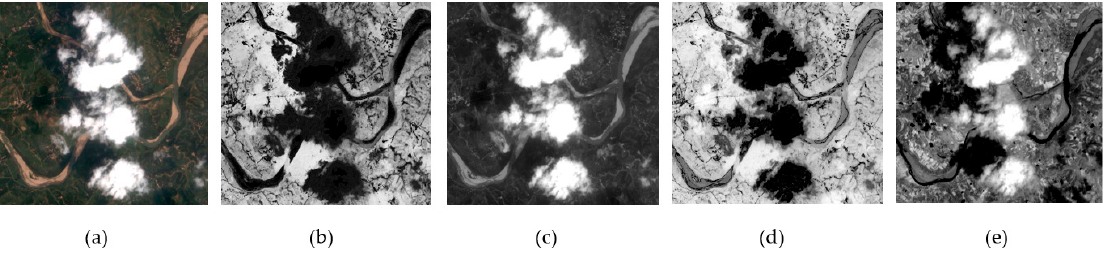
Figure 4. Basic features for cloud detection. ( a ) Original image; ( b ) Hue channel; ( c ) Intensity channel; ( d ) Saturation channel; ( e ) NIR channel.